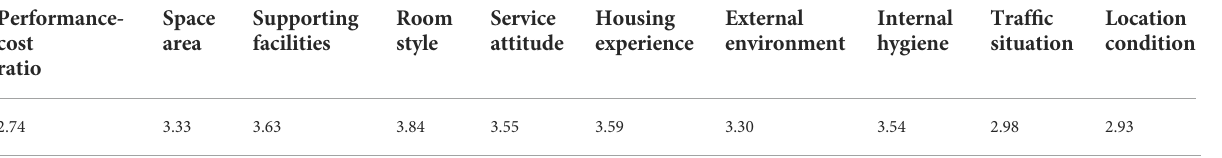
TABLE 8 Combined sentiment value of feature